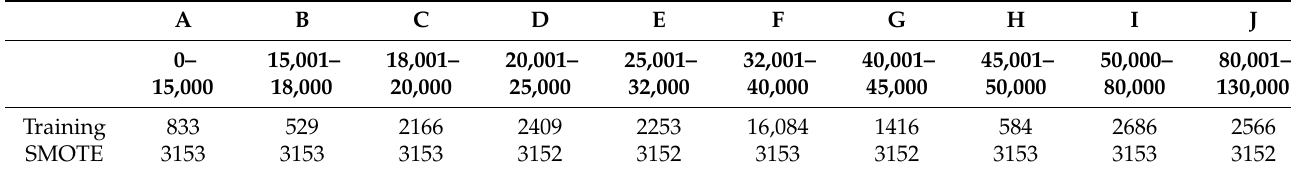
Table 3. The synthetic minority oversampling